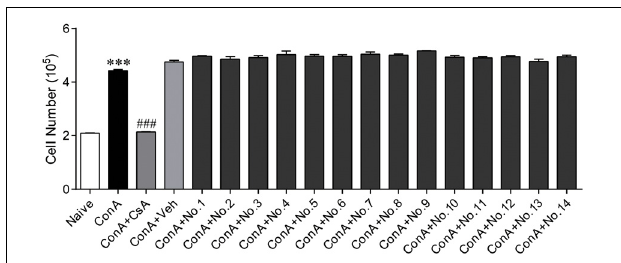
FIGURE 3 | Splenocyte proliferation in ConA-induced splenocytes treated with extracts of endophytic actinobacteria from Zijuan and Yunkang-10. Naive mouse splenocytes were stimulated with 5 µ g/mL of ConA in the presence of different extracts, and 500 ng/mL CsA was set as a positive control. No.1-YFT113, No.2-YXN120, No.3-YXN111, No.4-YXN112, No.5-YXT131, No.6-YKFG1221, No.7-YKFG1121, No.8-YKFG1122, No.9-YKFT1130, No.10-YKFH1122, No.11-YKFG1112, No.12-ZFY142, No.13-ZFG130, 14-ZJFT1121. Data are means ± SD ( n = 5), ∗∗∗ p < 0.001 vs. naive, ### p < 0.001 vs. ConA.